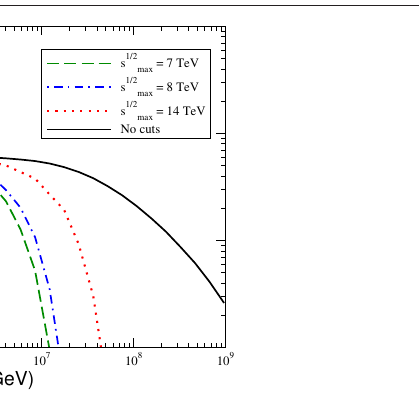
Figure 3. Impact of di ff erent cuts on the maximal center-of-mass pp collision energy for the prompt neutrino flux.